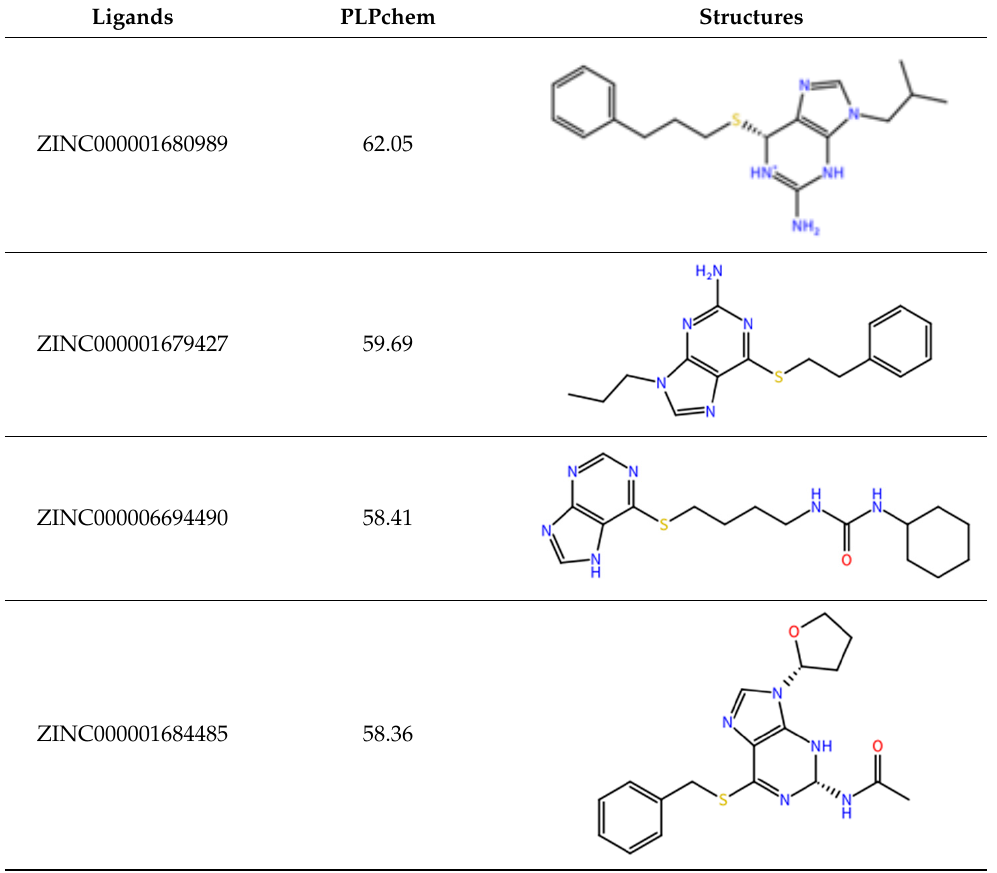
Table 1. PLPChem score values obtained in the GOLD program and the structures of the four selected compounds.